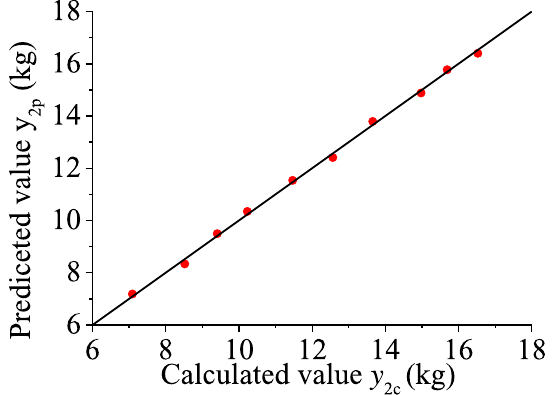
Fig. 18. Veri fi cation of Kriging surrogate model y 2 .